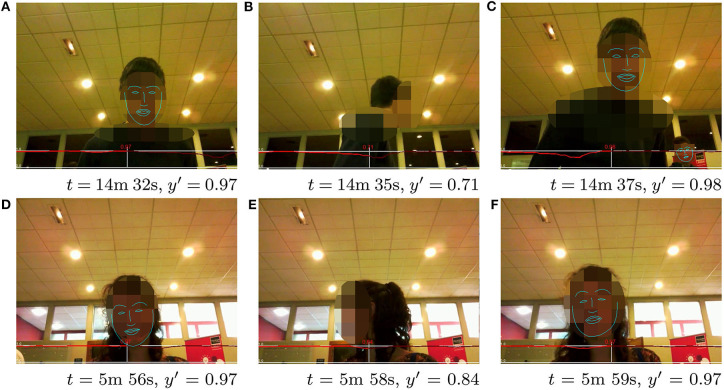
(A-F) UE-HRI dataset: two sequences of short timescale sequential frames showing how the temporal diverting of attention is reflected in the model predicting a lower engagement value. The red plot shows the predicted engagement values over the frame sequences, with the prediction y′ at the frame shown in the picture at time t being in the center, past predictions on the left and future predictions on the right. Faces from original dataset blurred for anonymisation; face landmarks added in postprocessing to indicate face orientation. Permission for re-use of the images has been obtained from the copyright holder.